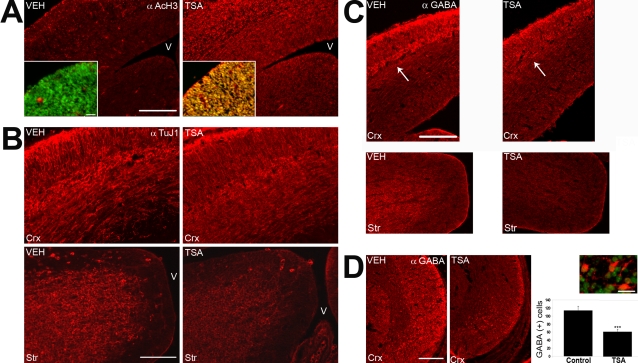
HDAC inhibition by TSA in utero results in a decrease of neurogenesis in the GE and a corresponding reduction in GE-derived GABA-positive cells undergoing tangential migration in the cortex.Timed-pregnant tauGFP mice were injected every 12 hours with vehicle (VEH) or with TSA (TSA) starting from 13.5 d.p.c., and embryos were examined at 15.75 d.p.c., using immunohistofluorescence with the indicated antibodies (upper right). In all panels, dorsal is at the top. Lateral is to the left (A, B, C) or the right (D) of each panel, respectively, and “V” indicates the ventricle. (A) Both cortex (upper portion of figure and inset) and GE (lower portion of figure to the right of the inset) show an increase in the acetylation of histone H3 upon TSA treatment, as revealed with an anti-acetylated-histone H3 antibody. Inset: red = anti-acetylated-histone H3 antibody, green = DAPI. (B) Using the TuJ1 antibody to detect newborn neurons, the GE (Str) shows a decrease in signal in TSA-treated embryos, reflecting a decrease in neurogenesis, while the cortex (Crx) looks essentially the same upon TSA treatment. (C) An antibody recognizing GABA labels GE-derived interneurons migrating tangentially in the intermediate zone of the cortex (Crx, arrow). This migrating population is substantially decreased in TSA-treated embryos. GABA-positive cells are also substantially decreased in GE (Str). (D) The number of GABA-positive cells (photos left, inset: red = anti-GABA, green = DAPI) were quantified in the ventrolateral cortex (Crx), reflecting the number of cells per slide in one hemisphere (graph: Mean values +/− SEM (n = 3). *** = p<0.001, Student's T-test. Scale bars: (A, C, D) 200 µm, (B) 100 µm, (A: inset) 25 µm, (D: inset) 20 µm.